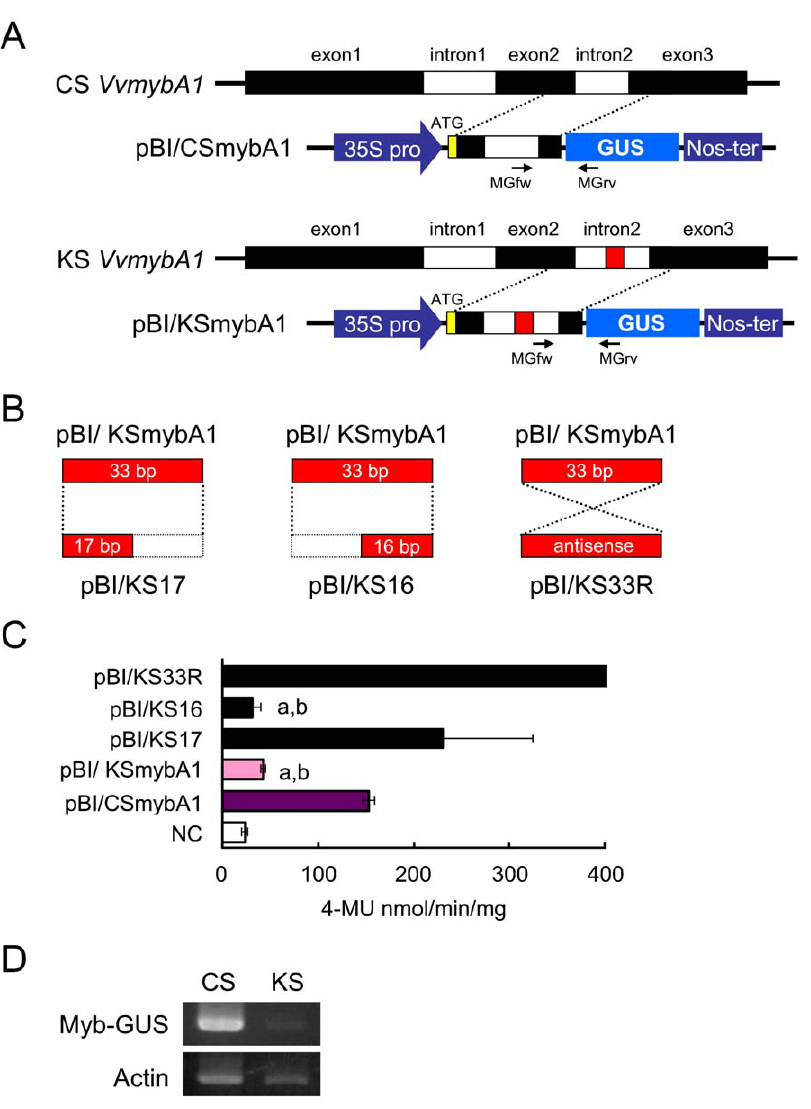
Figure 5. Effect of 33 bp short insertion on the transcription of a reporter gene. (A) Transformation constructs. Gene fragments from the second exon to the third exon, including the second intron, of Cabernet Sauvignon or Koshu MybA1 gene were inserted in front of the GUS reporter gene, resulting in pBI/CSmybA1 or pBI/KSmybA1 plant expression plasmids, respectively. Red boxes indicate the 33 bp short insertion in the second intron of Koshu MybA1 . Yellow boxes indicate the ATG start codon. 35S pro, 35S promoter. Nos-ter, Nos terminator. (B) A schematic representation of the deletion (pBI/KS17 and pBI/KS16) and antisense (pBI/KS33R) mutants for 33 bp short insertion. The plant expression vectors having these mutants were constructed by procedures detailed in Methods. (C) GUS activity. BY-2 cells transformed by the plant expression vectors were used. GUS activity in the graph is expressed as the amount of 4-MU produced in one minute by one mg of protein extracted from the cells. a, p , 0.01 as compared with pBI/CSmybA1. b, p , 0.05 as compared with non-transformant cells (NC). (D) RT-PCR analysis. MybA1 - GUS transcripts were detected by RT-PCR analysis using MGfw and MGrv primers. CS, pBI/CSmybA1. KS, pBI/KSmybA1. Myb-GUS, MybA1 - GUS mRNA. Actin, an internal control.